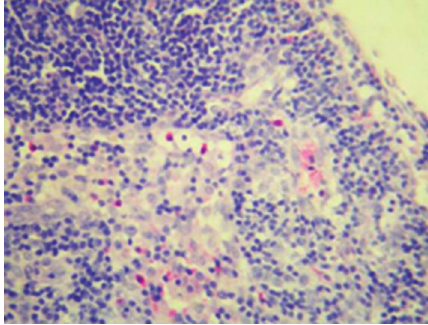
Figure 11: Treated group 28 days; enlargement and congestion of splenic sinusoid; HE × 200.